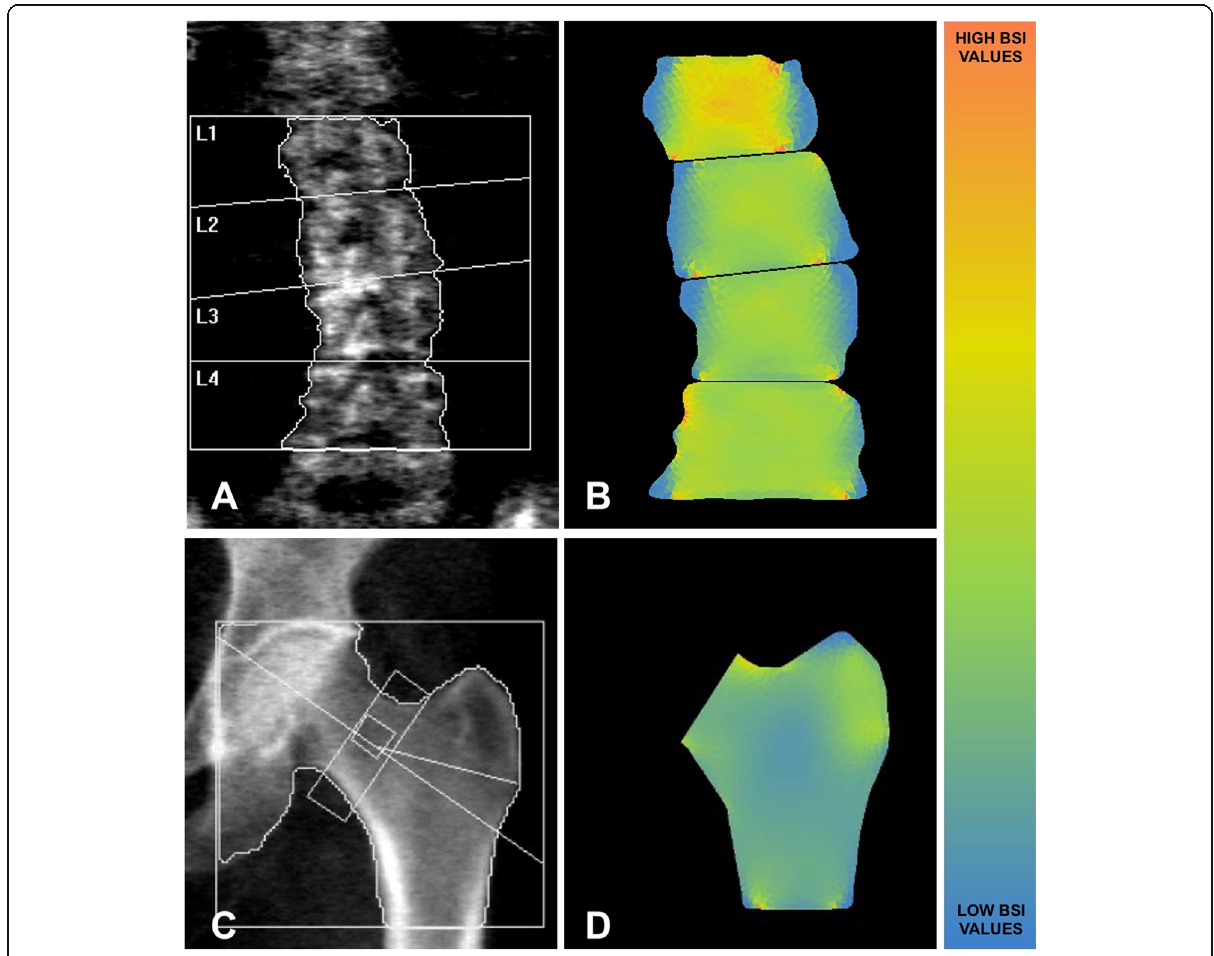
Fig. 2 An example of lumbar and femur DXA scans ( A and C , respectively) with corresponding BSI analysis ( B and D , respectively). On the right side, a bar explains the different colours of BSI values, with high BSI reported in red and low BSI reported in